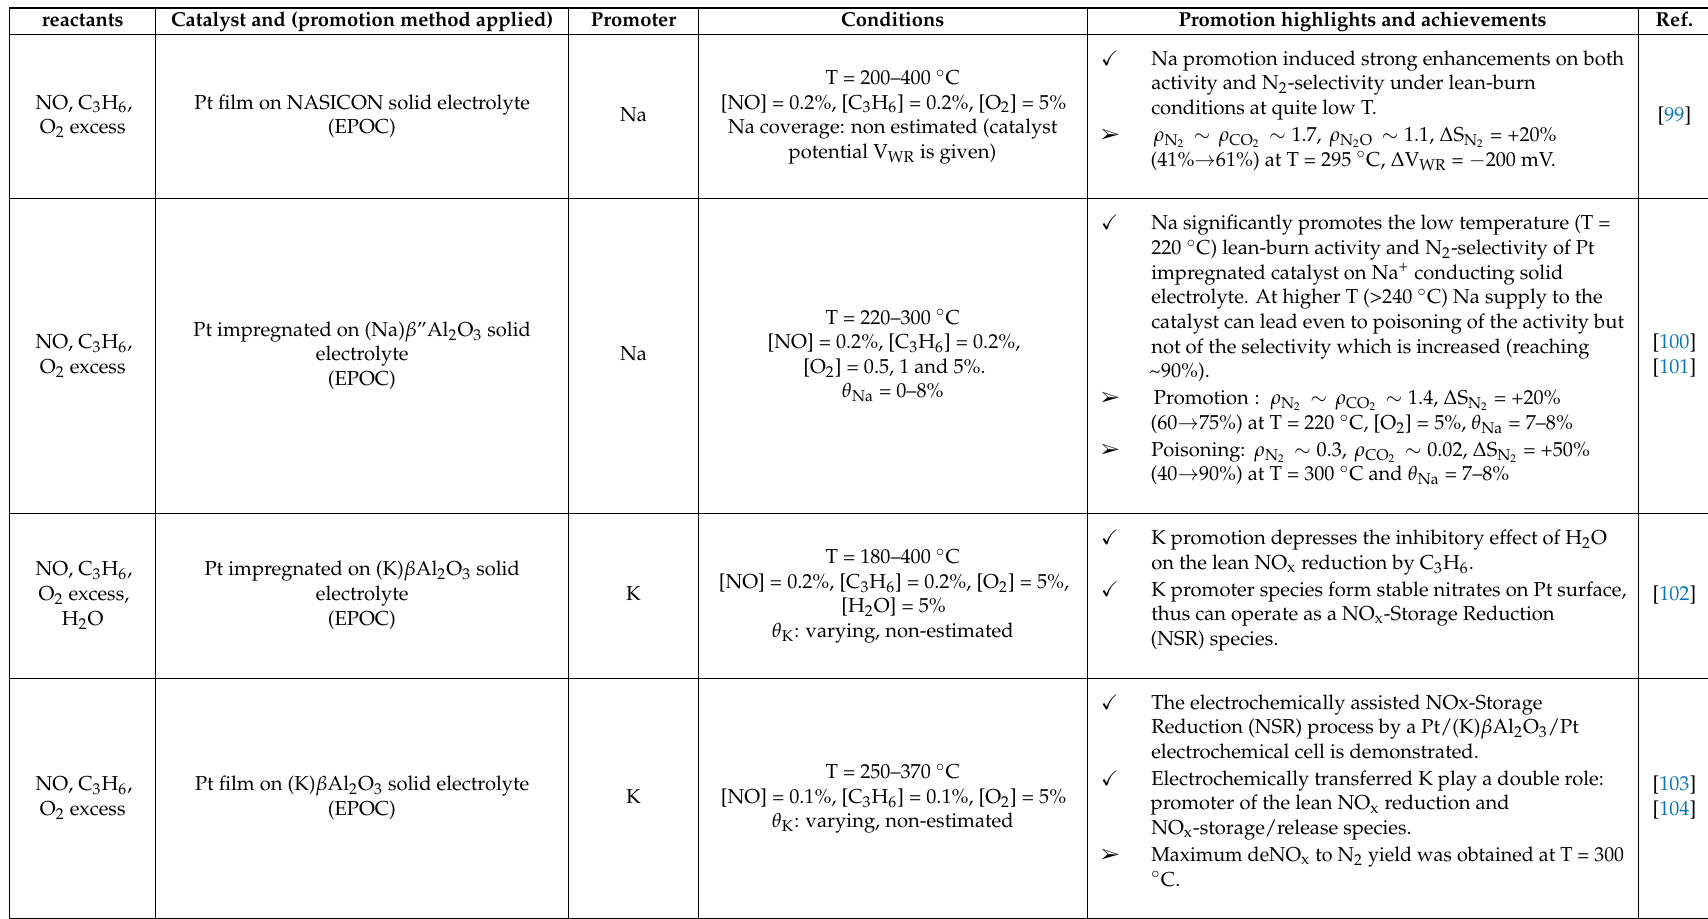
Table 7. Electropositive promotion of PGMs-catalysed lean-NO x reduction by C 3 H 6 (the so-called simulated lean-burn or diesel exhaust conditions). reactants Catalyst and (promotion method applied) Promoter Conditions Promotion highlights and